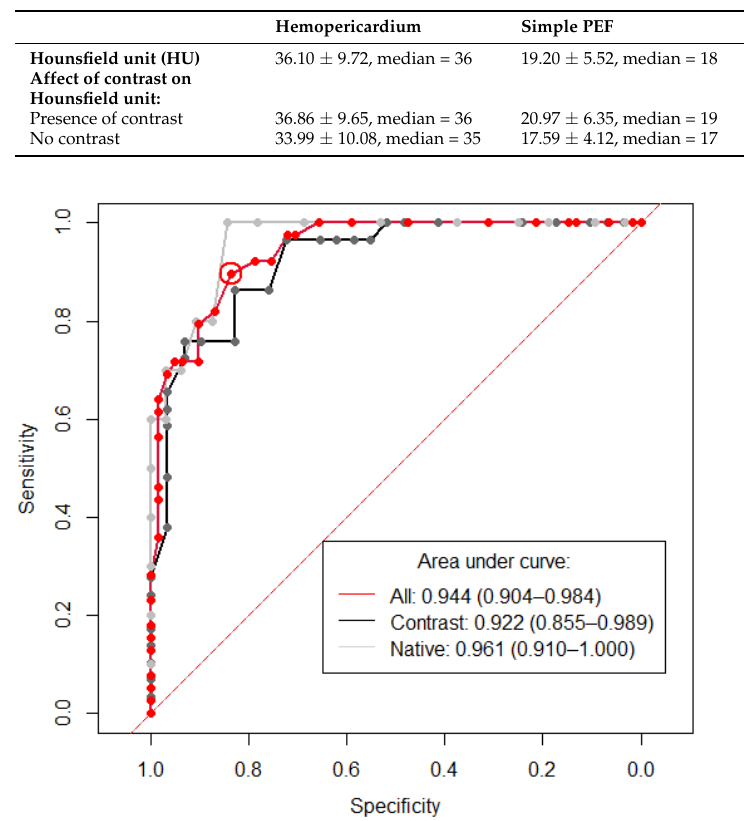
Figure 5. Receiver operating curve showing the sensitivity and specificity of Hounsfield units (HU) for the diagnosis of hemopericardium. The area under curve (AUC) is 0.944 (95% CI 0.904–0.984) for the whole positive cohort ( n = 100) (red line). A threshold of 24.5 was identified, which is encircled in red and shows the value for the calculation of both Youden’s formula and the “closest top left” formula. The x and y values of this datapoint are 0.897 (specificity) and 0.836 (sensitivity), respectively. Labeled in black are all positive cases with contrast ( n = 58). Here, a threshold of 26.5 was calculated using Youden’s formula, with a sensitivity and specificity of 0.862 and 0.828 respectively. Labeled in gray are all positive cases without contrast ( n = 42). A threshold of 21 was calculated using Youden’s formula, with a sensitivity and specificity of 1.00 and 0.844, respectively. The dashed red line demonstrates the location of an AUC of 0.5, which is a random classifier and would, therefore, be of no diagnostic